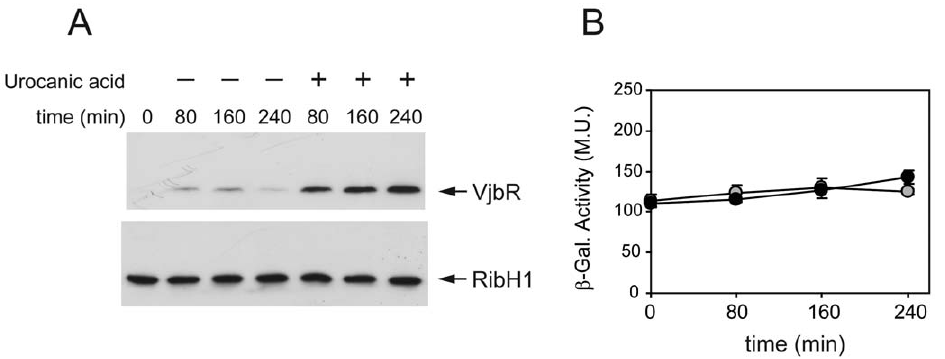
Figure 3. Analysis of expression of VjbR at pH 5.5 between 0 and 4 hours. (A) Wild-type strain B. abortus 2308 was grown in TSB until OD 600 # 1.5. Subsequently, cultures were centrifuged and bacteria were resuspended in medium MM1 at pH 5.5 in the absence or presence of 5 mM urocanic acid. At the indicated times, OD 600 was determined, and samples were analyzed by western blot using anti-VjbR or anti-RibH1 polyclonal antibodies. Results are representative from one of two independent experiments. (B) Analysis of vjbR promoter activity. Strain B. abortus P vjbR - lacZ was cultured in TSB and shifted to MM1 at pH 5.5 in the absence (gray circles) or presence (black circles) of 5 mM urocanic acid. Subsequently, b - galactosidase activities were determined at the indicated times. Values are means 6 standard deviations of duplicate samples from a representative of two independent